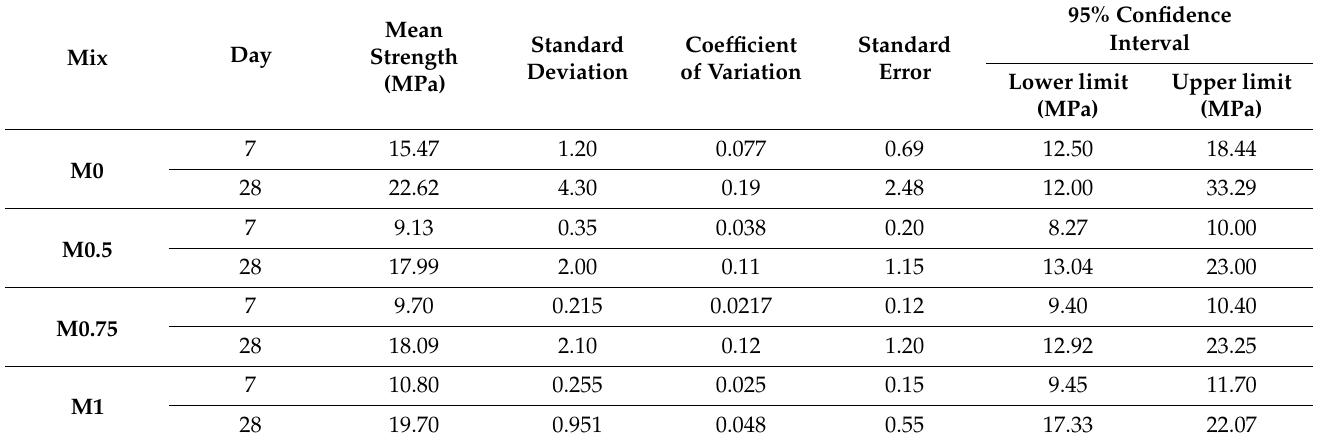
Table 7. Compressive strength test results summary.